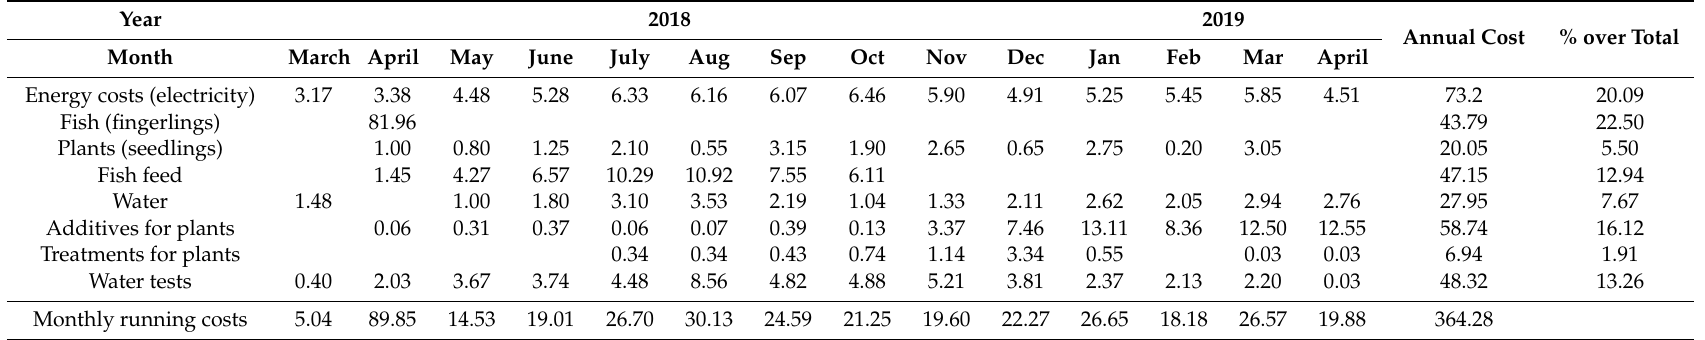
Table A4. Monthly ( € month-1) and annual ( € year-1) running costs for SAS2. Percentage of each input of the total (%) (VAT